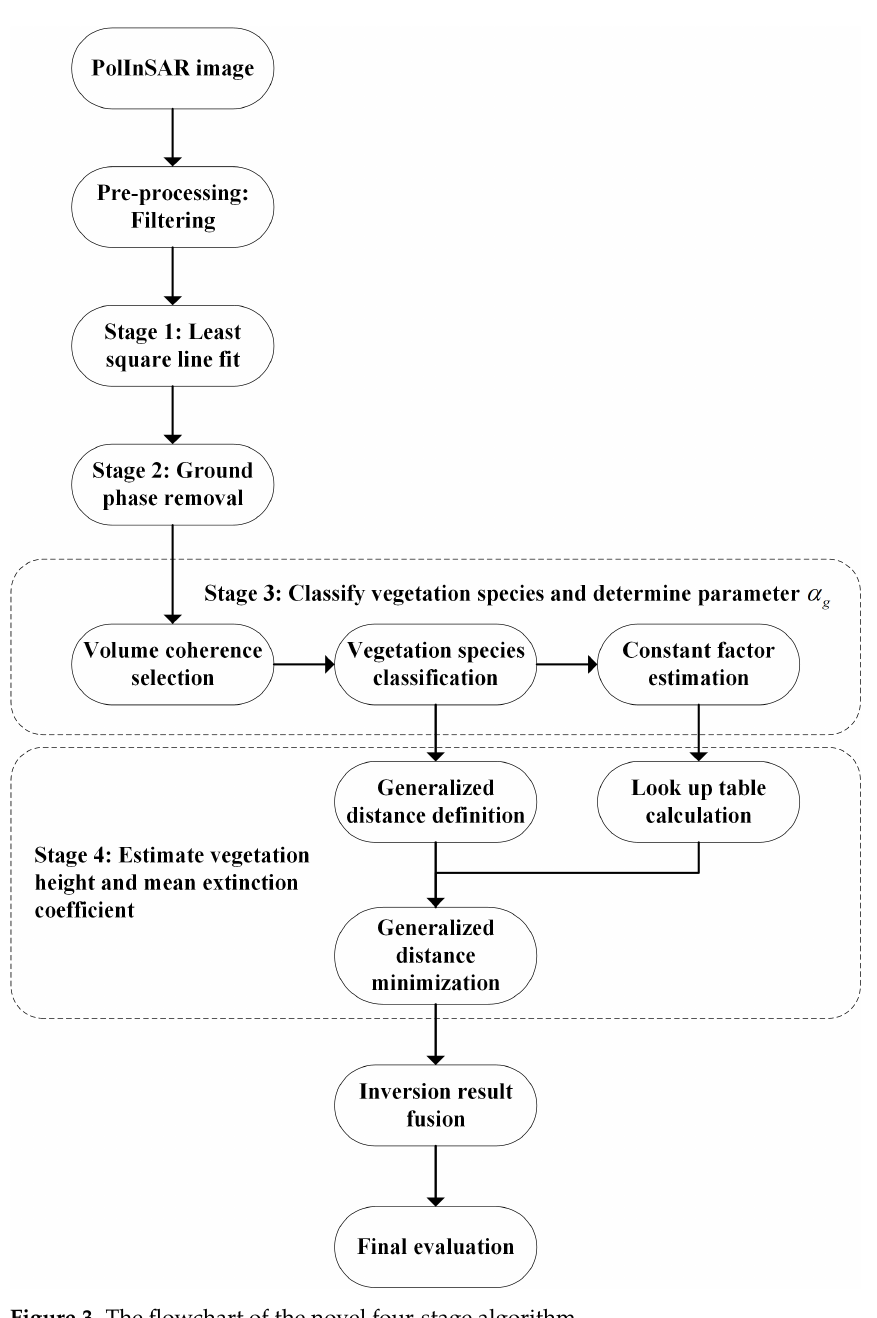
Figure 3. The flowchart of the novel four-stage algorithm.